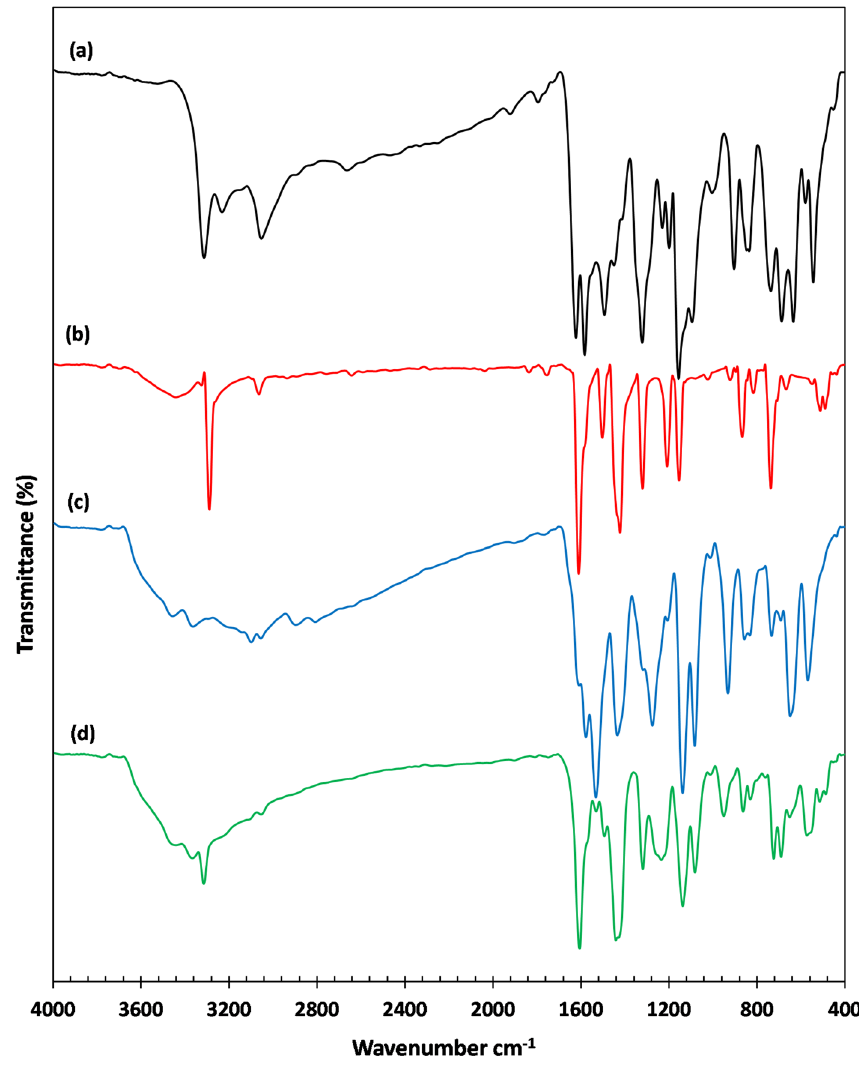
Figure 3. FT-IR of ( a ) SB 3 , ( b ) [Ni(SB 3 –H)(OH)(H 2 O)], ( c ) SB 5 , ( d ) [Ni(SB 5 –H)(OH)(H 2